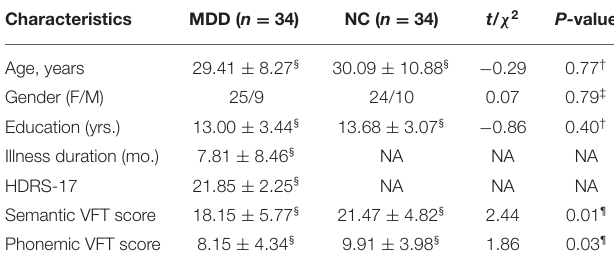
TABLE 1 | Demographic characteristics and VFT performance of the participants.